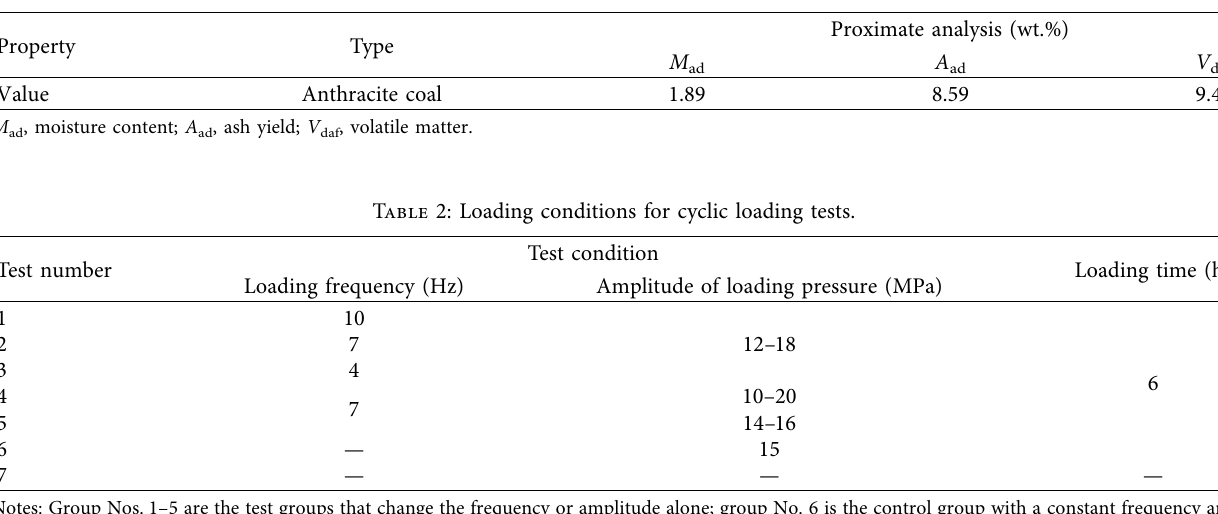
Table 1: Basic properties of the coal samples.